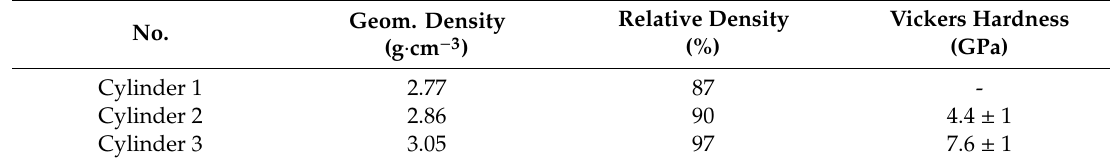
Figure 3. XRD pattern of TiB 2 -Si composite after selective laser melting (SLM) (I = 1400 mA). Table 4. Density and hardness results of TiB 2 -Si solid parts.